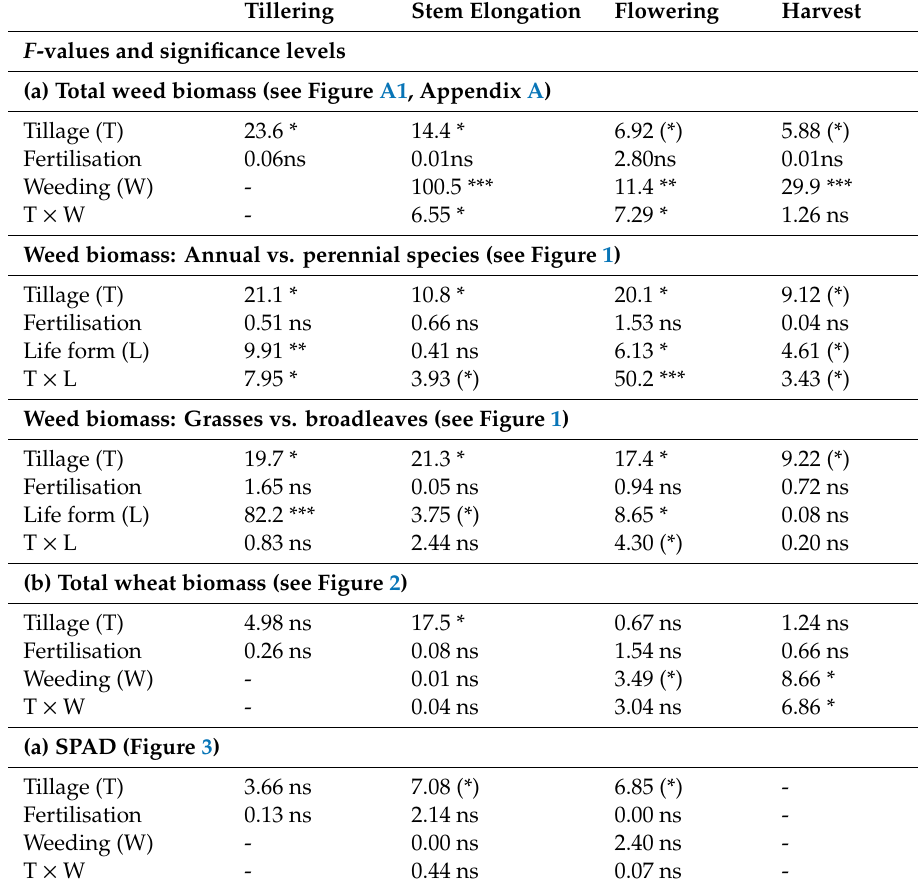
Table 1. Statistical results of tillage, fertilisation and weed specific e ff ects on (a) total weed and biomass of di ff erent life forms, (b) wheat biomass and (c) SPAD scores at di ff erent wheat stages. Interactions with fertilisation were not significant and therefore excluded for